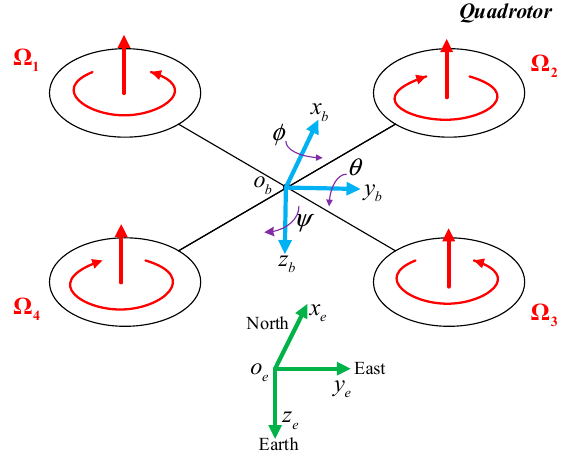
Figure 1. Schematic view of the quadrotor unmanned aerial vehicles (QUAV).